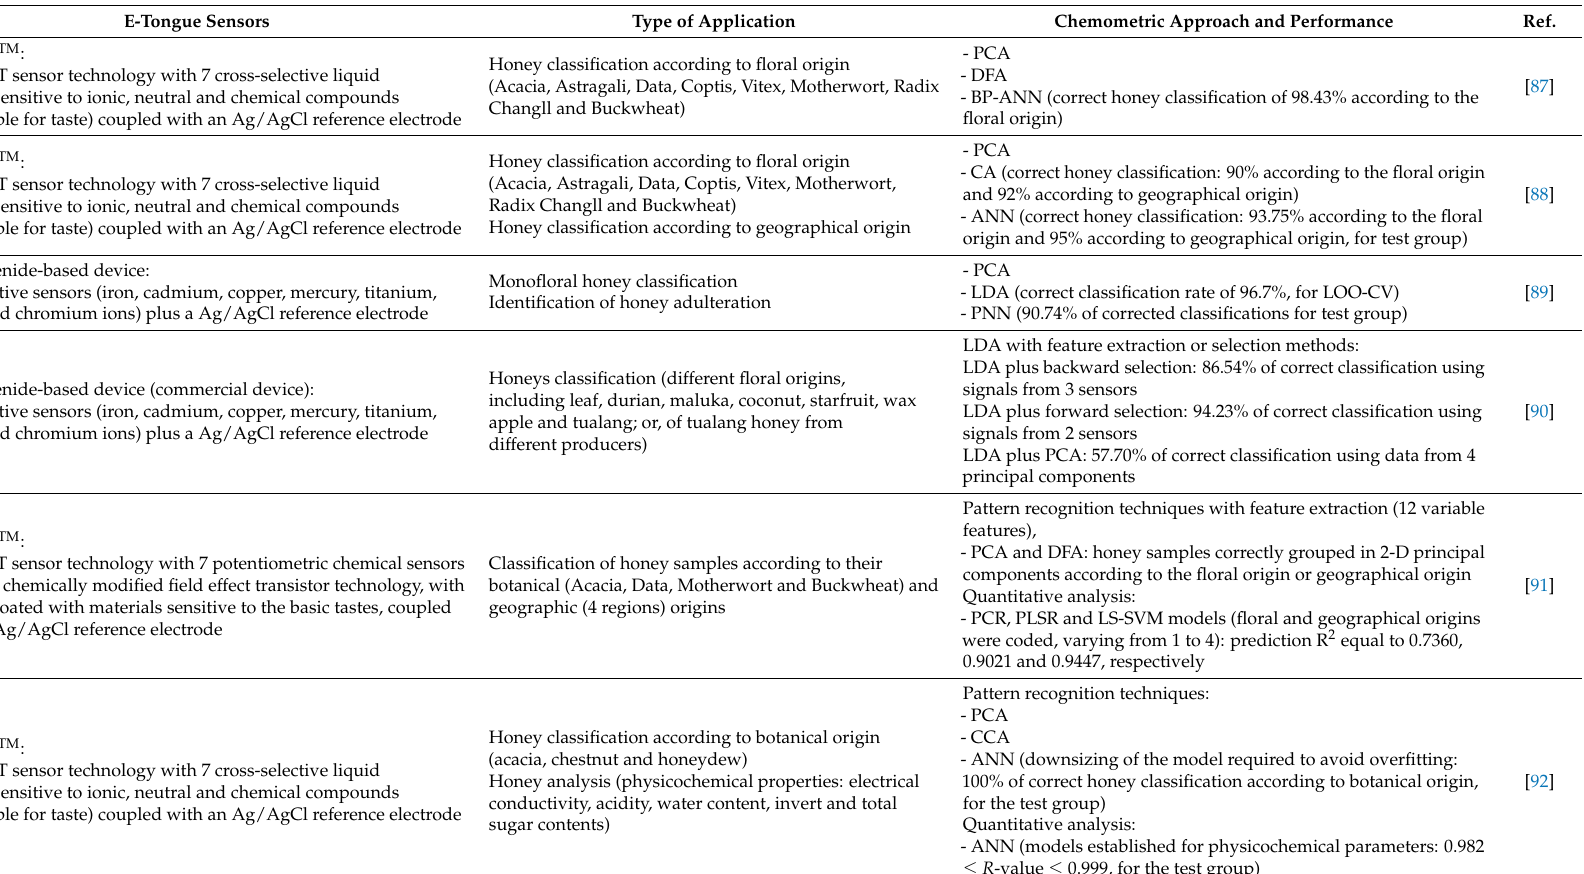
Table 1. Honey evaluation using commercial potentiometric E-tongue based